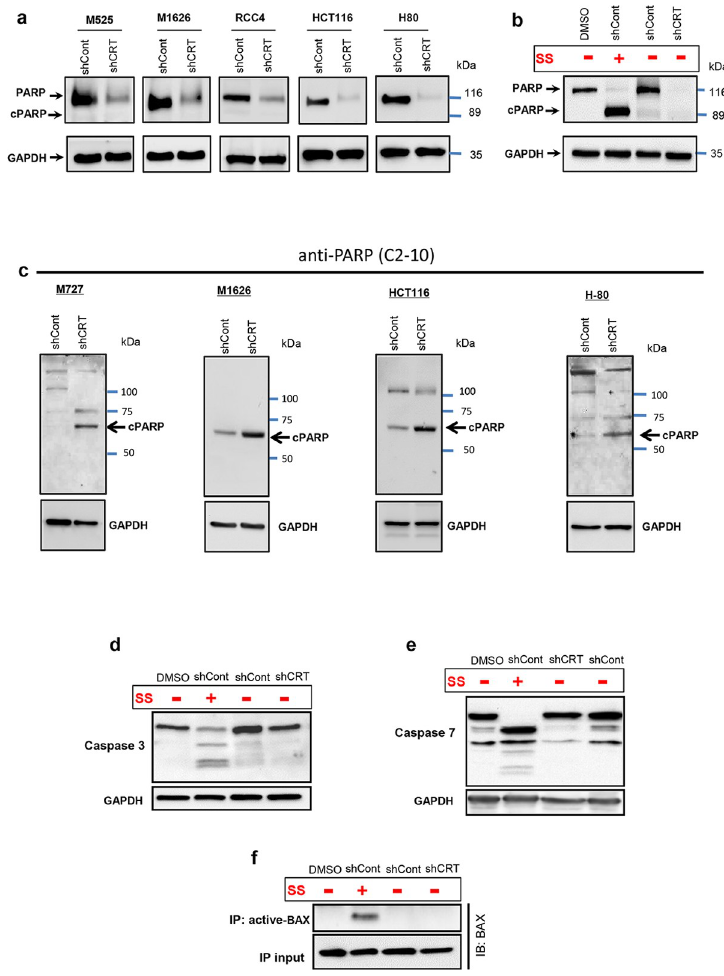
Fig 3. Tumor cell death in response to CRT down-regulation is executioner caspase independent. (A) Western blot analysis of PARP full-length and apoptosis specific cleaved protein fragments (cPARP) in an indicated types of malignant cells following CRT knockdown. (B) Western blot analysis of full-length and cleaved PARP fragment following treatment of cells with apoptosis inducing agent, SS. (C) Western blot analysis of necrosis-specific PARP cleavage fragments using C2-10 anti-PARP mAb in the indicated solid-tissue malignancies transduced with shCRT and shCont. Western blot analysis of the cleaved Caspase-3 (D) and Caspase-7 (E) proteins in the cells following CRT knockdown or SS treatment. (F) Immuno blot of total BAX after IP with antiactive-BAX antibody; 10% of IP input was used as a loading control for BAX. BAX, BCL2-associated X protein; cPARP, cleaved poly ADP ribose polymerase; CRT, calreticulin; GAPDH, Glyceraldehyde 3-phosphate dehydrogenase; HCT, Human colorectal carcinoma cell line; IB, immunoblot; IP, immunoprecipitation; mAb, monocloncal antibody; PARP, poly ADP ribose polymerase; RCC, Human clear cell renal cell carcinoma cell line; shCont, short hairpin RNA targeting Control; shCRT, short hairpin RNA targeting Calreticulin; SS, Staurosporin.